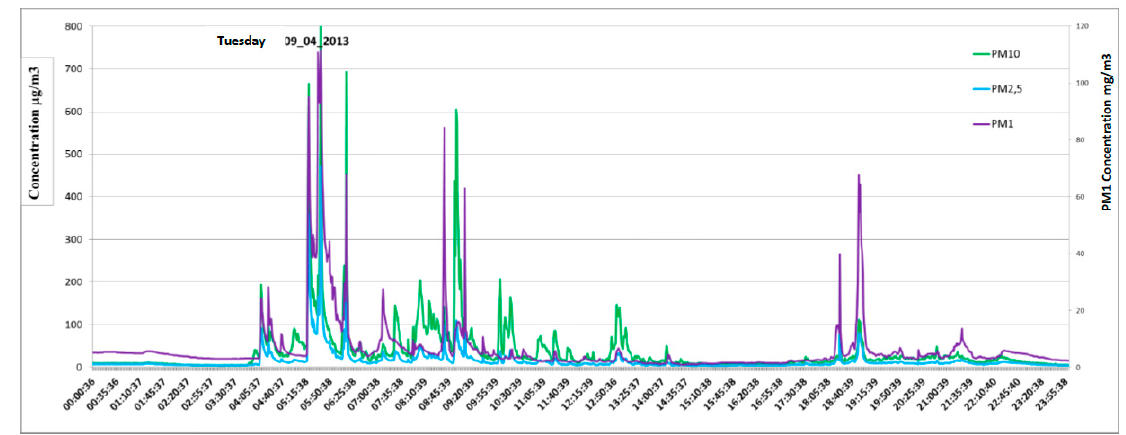
Figure 1. Typical OPC PM 10 , PM 2.5 and PM 1 concentration trend during a working day (09 April 2013) in the bakery.